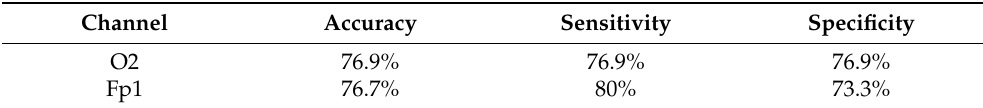
Table 7. Classification performance for O2 and Fp1 channels achieved by both the KNN and SVM